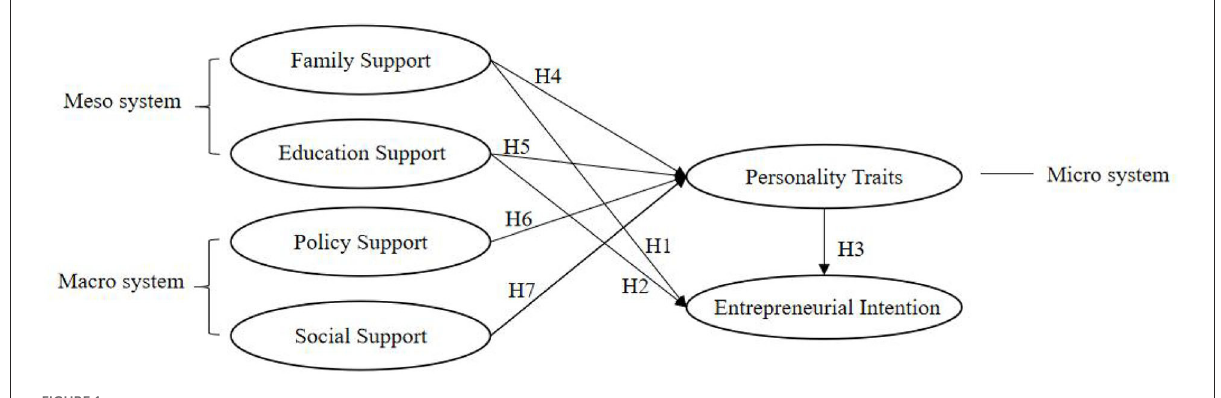
FIGURE1 Conceptual